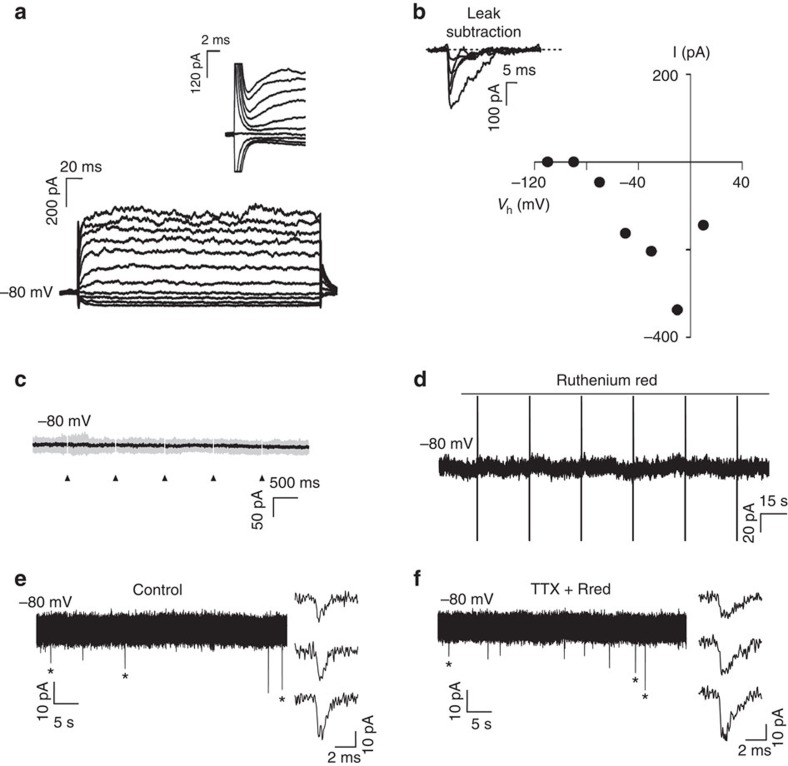
Myelination occurs in absence of axon-OPC AMPAR-mediated synaptic currents.(a) Currents elicited in a recorded OPC held at −80 mV 1 day after plating by voltage steps from +20 to −110 mV. Note the presence of sodium currents (inset). (b) I–V curve of sodium currents for the same OPC after leak subtraction (inset). (c) Lack of evoked synaptic currents in an OPC upon DRG axonal stimulation. There was no response in 74 cells tested (unstimulated n=17 cells, from seven dishes; pre-stimulated electrically with (n=15 cells from six dishes) or without (n=42 from 17 dishes) BoNT/A). Individual (grey, 15 sweeps) and average traces (black) are shown. Axonal stimulation time is indicated with arrowheads. (d) Bath application of the secretagogue ruthenium red (75 μM) in absence of electrical DRG axonal stimulation did not evoke any currents in the same OPC. Capacitive currents in response to a test pulse are shown (unstimulated n=10 cells from four dishes, pre-stimulated n=18 cells from seven dishes and pre-stimulated with BoNT/A n=7 cells from four dishes). (e,f) Spontaneous (e) and miniature (f) synaptic currents in an OPC recorded at 15 postnatal days in acute coronal corpus callosum slices of NG2-DsRed mice (N=2 mice). Miniature synaptic currents were recorded in 1 μM tetrodotoxin (TTX) and 75 μM ruthenium red (Rred). The mean frequency, rise and decay times of spontaneous synaptic activity are 0.51 Hz, t10–90%=332 μs and τ=1.35 ms, respectively (insets, n=7 cells from seven different brain slices). The holding potential is indicated for each trace.